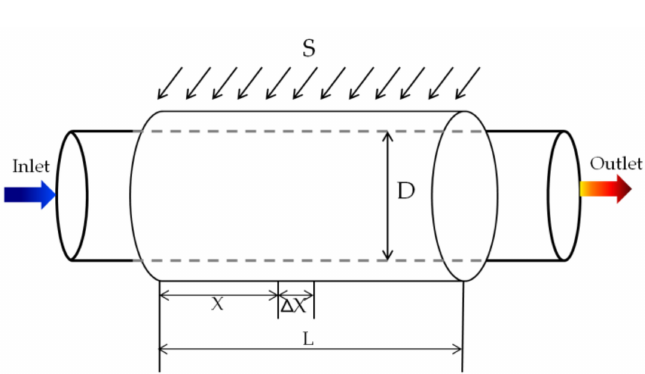
Figure 8. Schematic diagram of partial tube section under solar radiation.